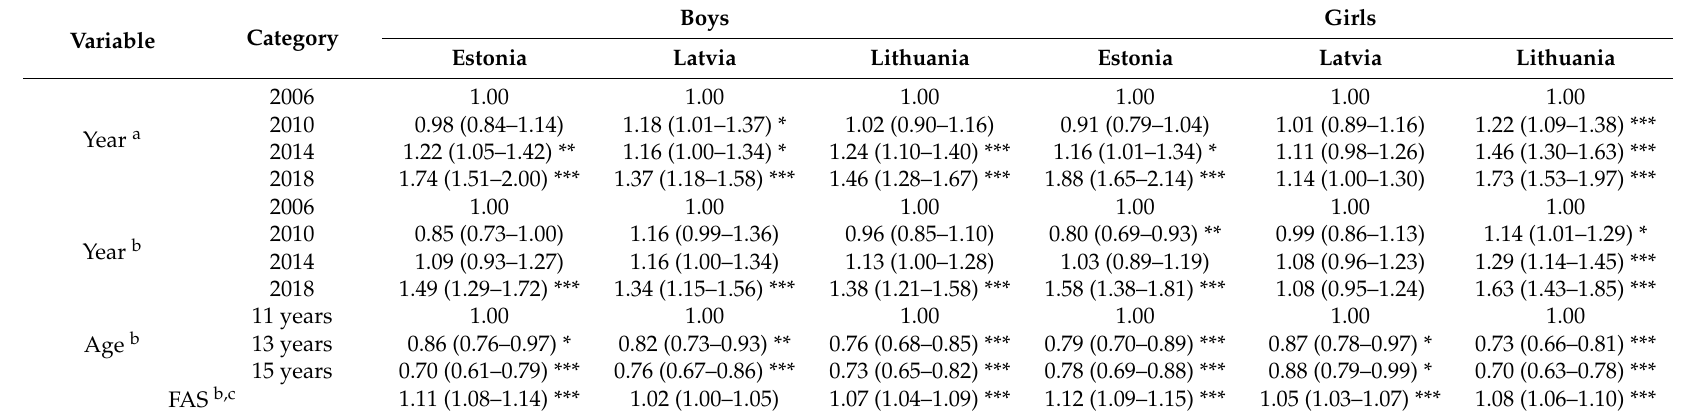
Table 4. Consumption of vegetables daily by survey year, age group and family a ffl uence (odds ratios and 95% confidence intervals).